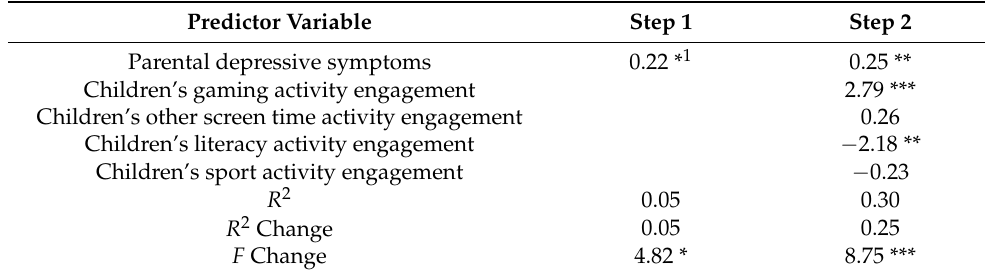
Table 4. Hierarchical regression model testing the role of parental depressive symptoms and leisure activity engagement on children’s GD symptoms ( n = 104).